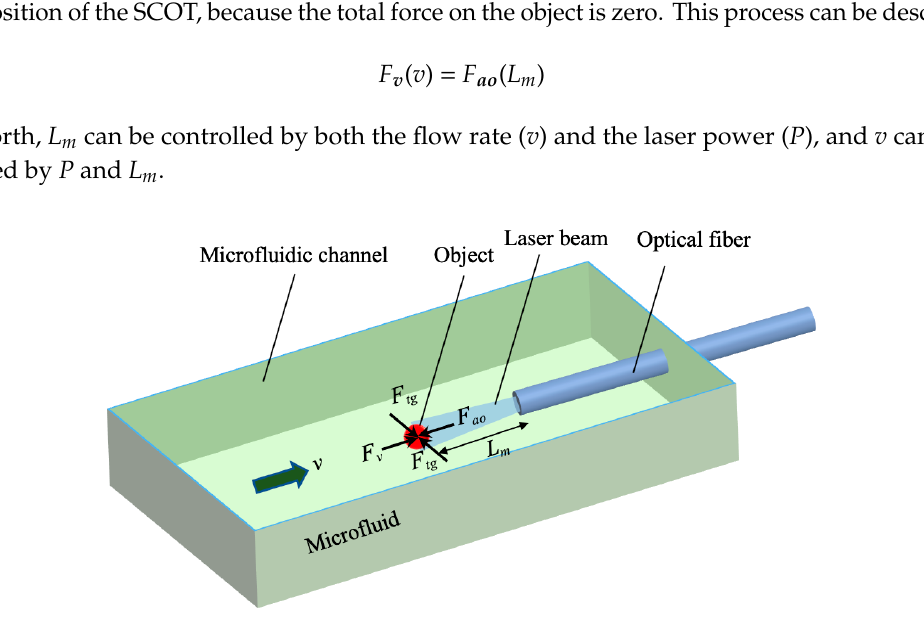
Figure 6. The principle of the stable combined optical trap based on a single optical fiber tip.